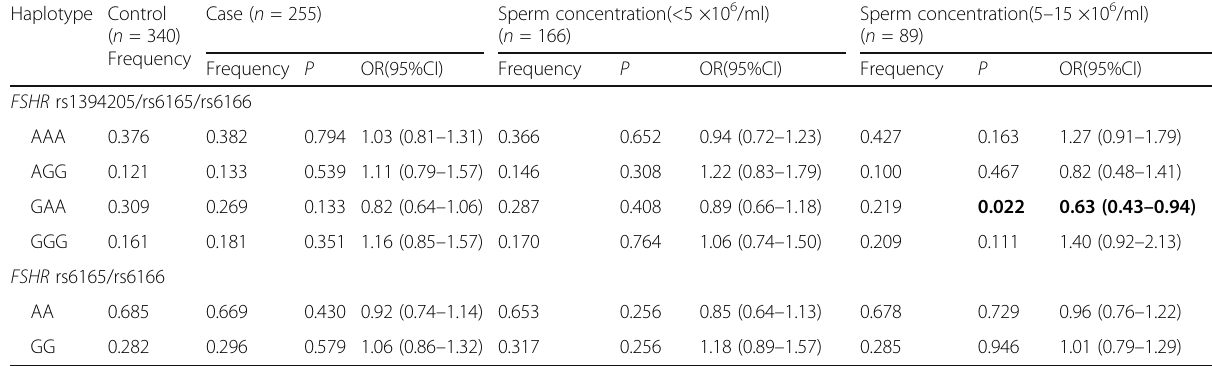
Table 3 Haplotype analysis of the FSHR three SNPs rs6165, rs6166 and rs1394205 Haplotype Control ( n =